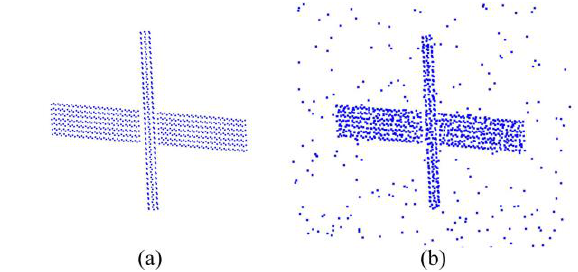
Figure 9. The illustration of synthetic point clouds. a) Original point cloud. b) Point cloud with MN and BG noise.